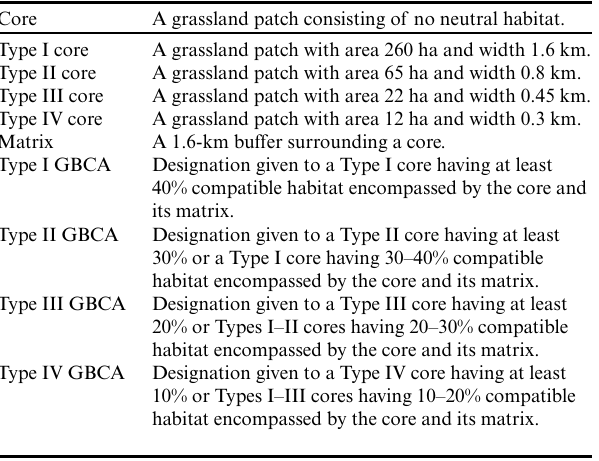
Table 3 . Criteria for classification of Types I–IV Grassland Bird Conservation Areas (GBCAs). Modified from Johnson et al. (2010).